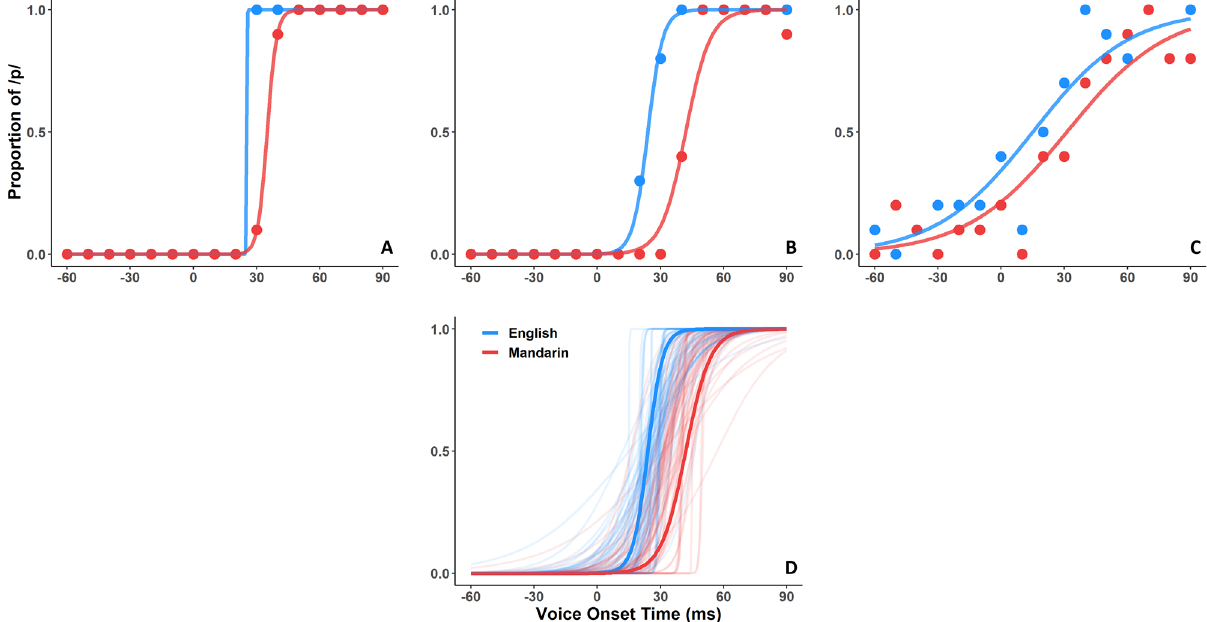
Figure 3. Psychometric curve fitting for three individuals with highest ( A ), median ( B ) and lowest slope values ( C ). Psychometric curves for all 66 participants, with median participant highlighted ( D ). Each language shown